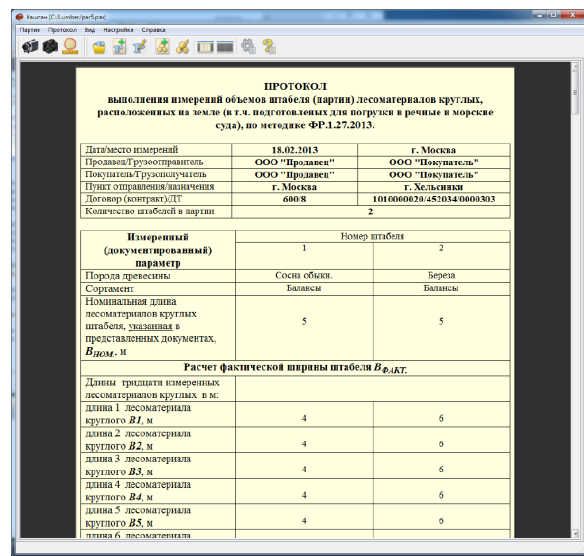
Figure 12. Final report with measurement results It contains all necessary information on given log stack including type of measured wood, overall stack volume, stacking coefficient, log length and all measured data with images, used for